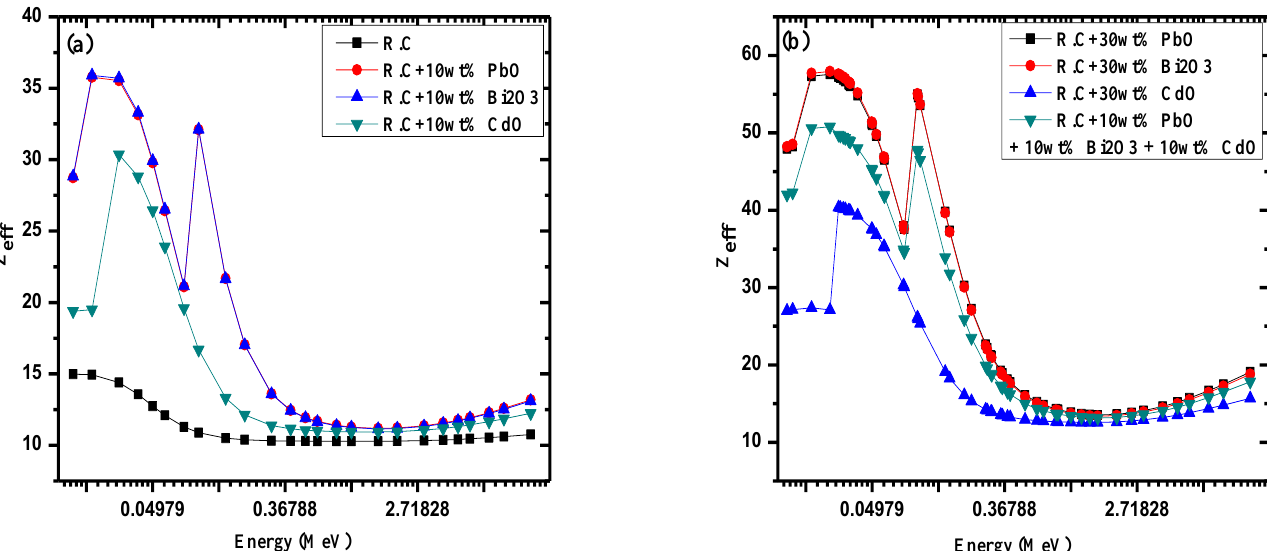
Figure 5. The effective atomic number as a function of energy, ( a ) Z eff of pure redl-clay as well as same the clay filled with 10%wt different oxides, and ( b ) Z eff of ball-clay filled with 30%wt different oxides.